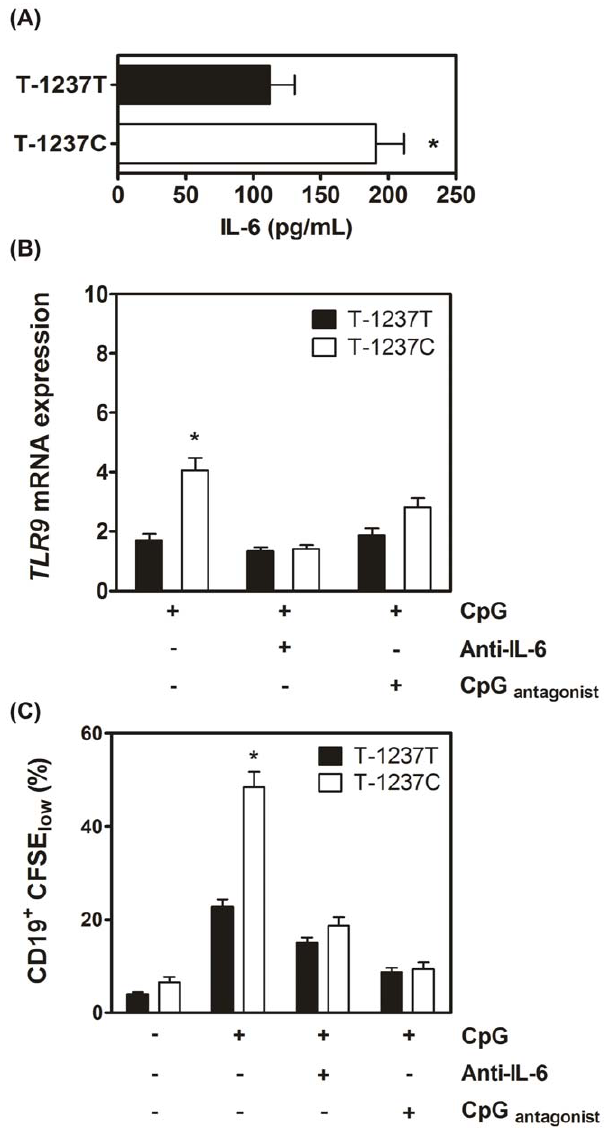
Figure 2. Human PBMCs carrying the TC genotype of rs5743836 stimulated via TLR9 show increased transcription of TLR9 and enhanced B-cell proliferation. (A) TC PBMCs secrete higher amounts of IL-6 upon activation of TLR9 with CpG ODN 2006. IL- 6 production was quantified by ELISA in the supernatants of TT (n=22) or TC (n=17) PBMCs following culture with CpG. (B) TLR9 activation of TC cells by CpG ODN 2006 increases TLR9 gene expression. Quantification of TLR9 mRNA expression in either TT (n=24) or TC (n=27) PBMCs cultured with: CpG ODN 2006 (0.05 m M); CpG ODN 2006 and anti-IL-6 antibody; CpG ODN 2006 and the TLR9 antagonist CpG ODN TTAGGG in a 1:2 ratio. (C) Proliferation of CD19 + cells was assessed by CFSE dilution in PBMCs with different rs5743836 genotypes, TT (n=40) and TC (n=33), left untreated or stimulated with: CpG ODN 2006 (0.05 m M); CpG ODN 2006 and anti-IL-6 antibody; CpG ODN 2006 and CpG ODN TTAGGG in a 1:2 ratio. Results shown are the means 6 SD.